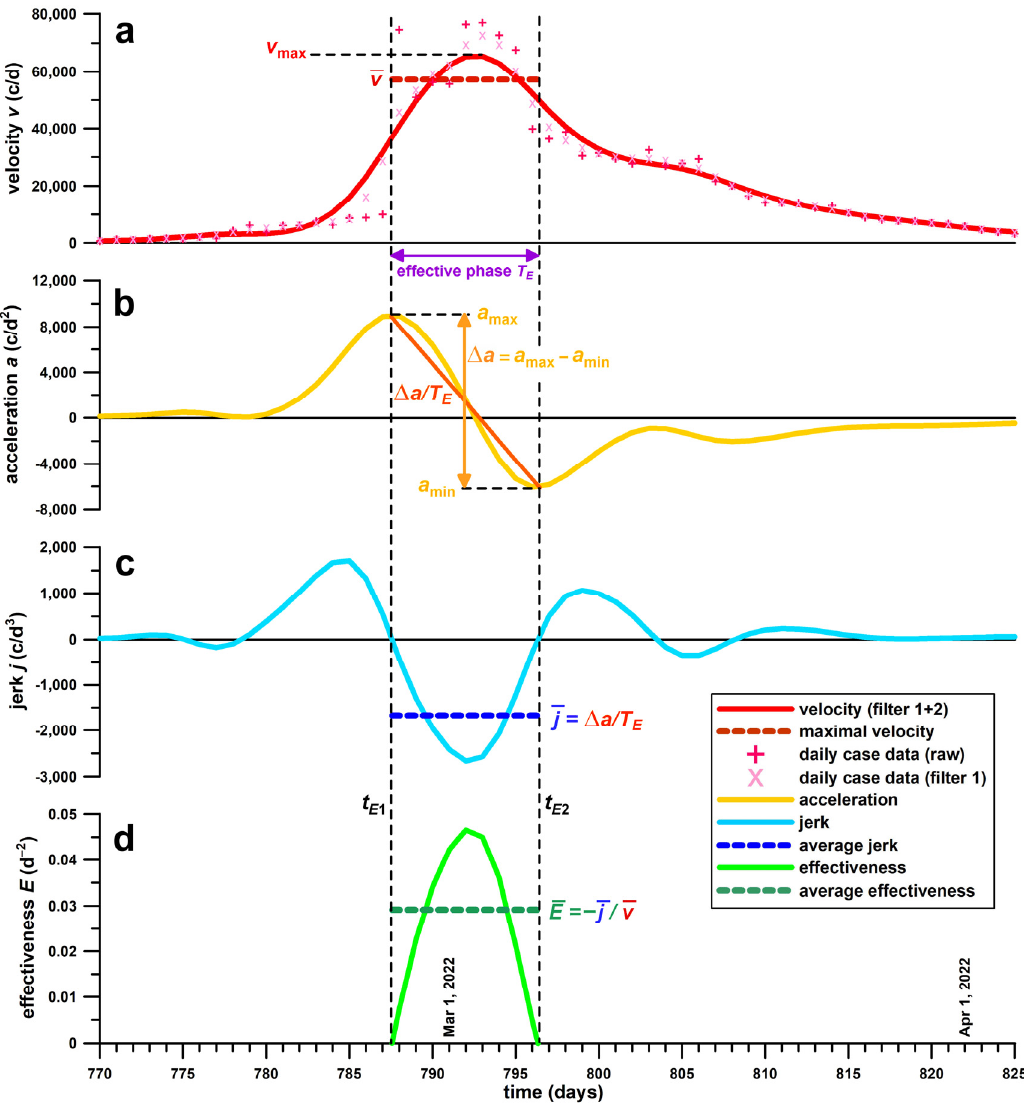
Figure 2. Dynamics of the Omicron wave in Hong Kong; ( a ) velocity (daily case data) against the time (in days; day 1 = 1 January 2020), v max = peak velocity of filtered data, v = average velocity of the effective phase; ( b ) acceleration against time, a max = maximum acceleration, a min = minimum acceleration (maximum deceleration), Δ a = acceleration differential during the effective phase, T E = duration of the effective phase; ( c ) jerk against time, j = average jerk across the effective phase; ( d ) effectiveness against time, t E 1 & t E 2 = start and end of the effective phase, E = average effectiveness across the effective phase.